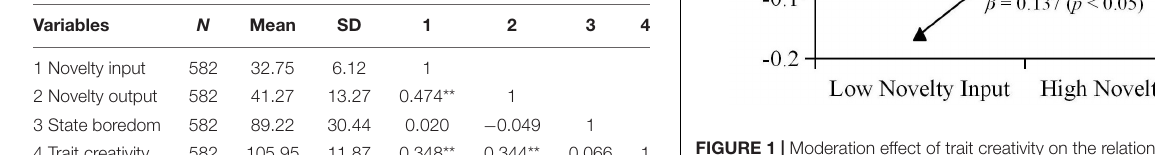
FIGURE 1 | Moderation effect of trait creativity on the relationship between novelty input and